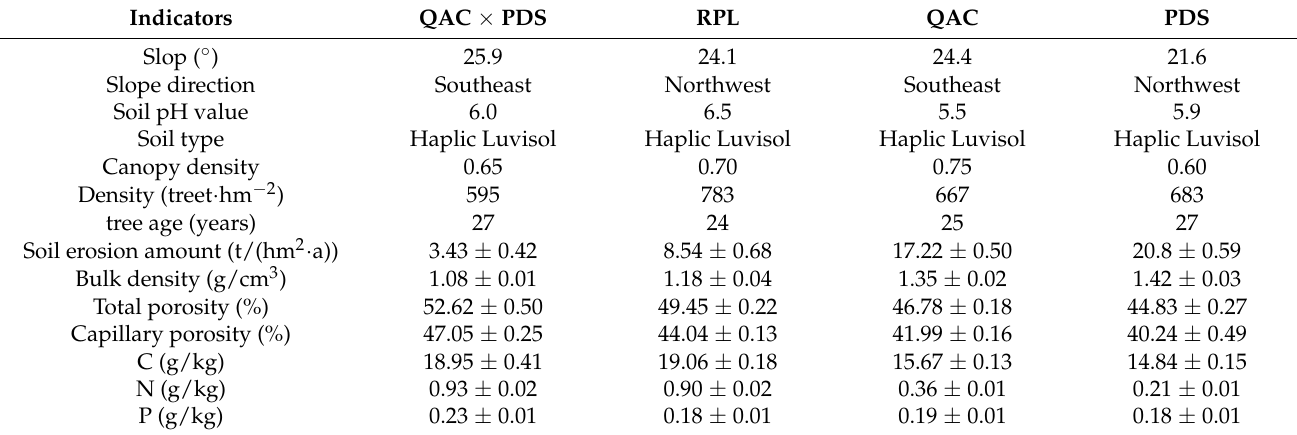
Table 1. The basic status of the study